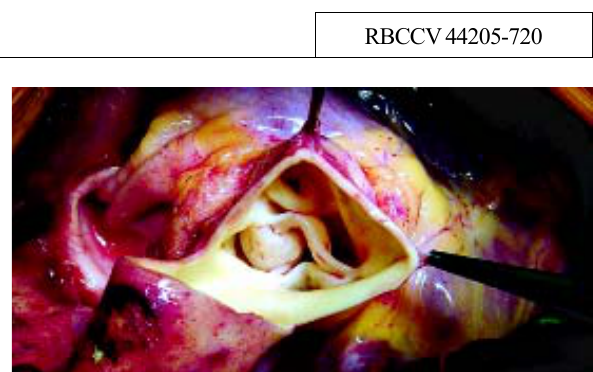
Fig. 1 – Aortotomia transversal demonstrando a face aórtica do